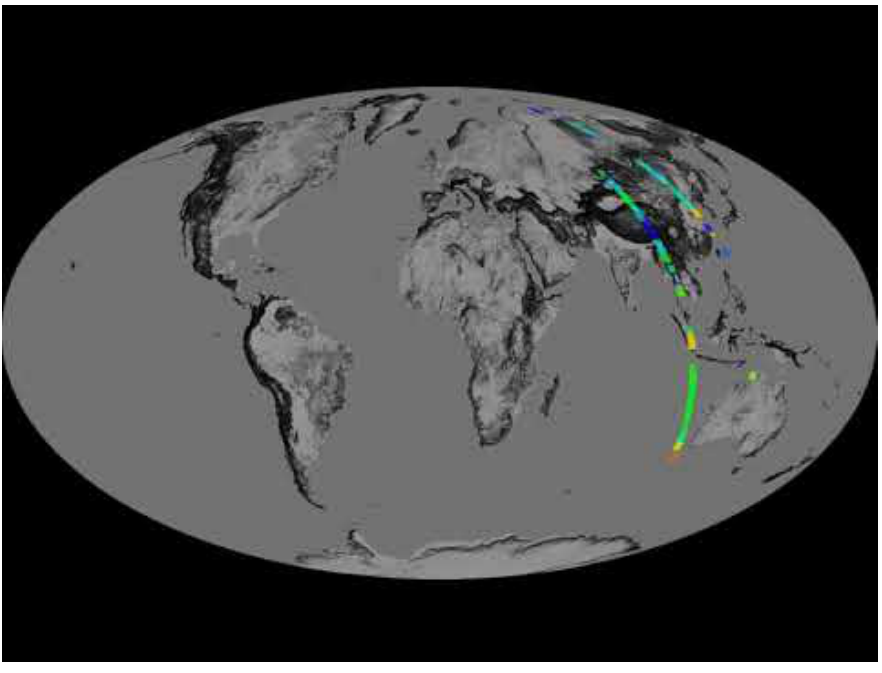
Figure 3: Clip from climate model visualization Assimilation of OCO-2 Carbon Dioxide into the GEOS Simulation (2016) showing data points from the OCO-2 satellite. Source: Clip made by author from original by NASA Scientific Visualization Studio. Available at https://svs.gsfc.nasa.gov/4519. URL: